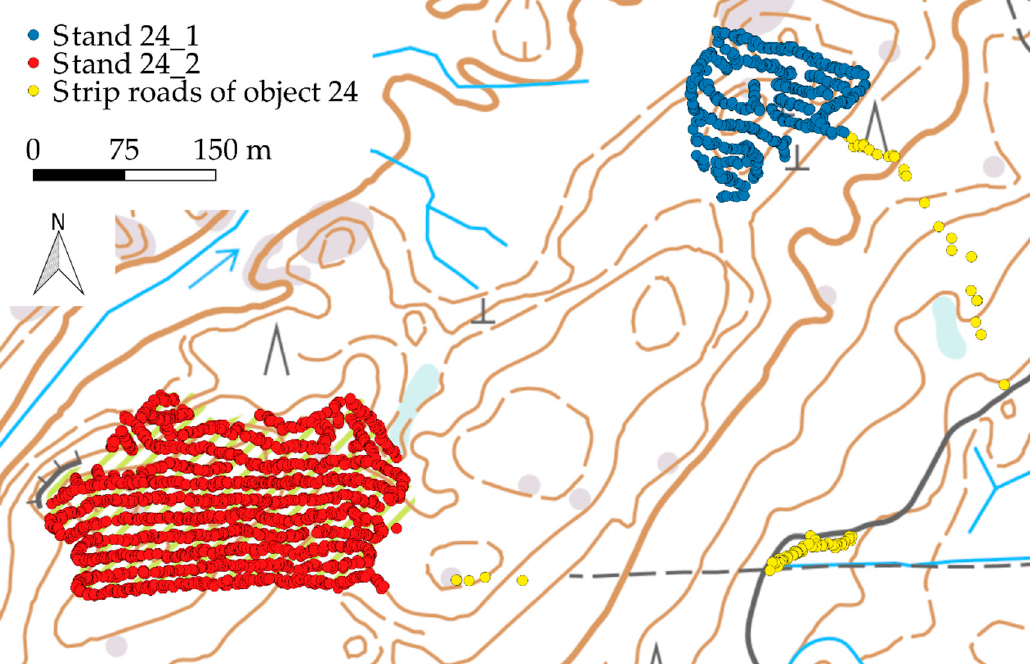
Figure 3. Example of results of Algorithm A1 at clear cutting object. The trees of the object have been separated into two geographically separate stands and external strip road trees. The ETRS-TM35FIN (EPSG:3067) coordinate system is used in the figure. Base map © National Land Survey of Finland.